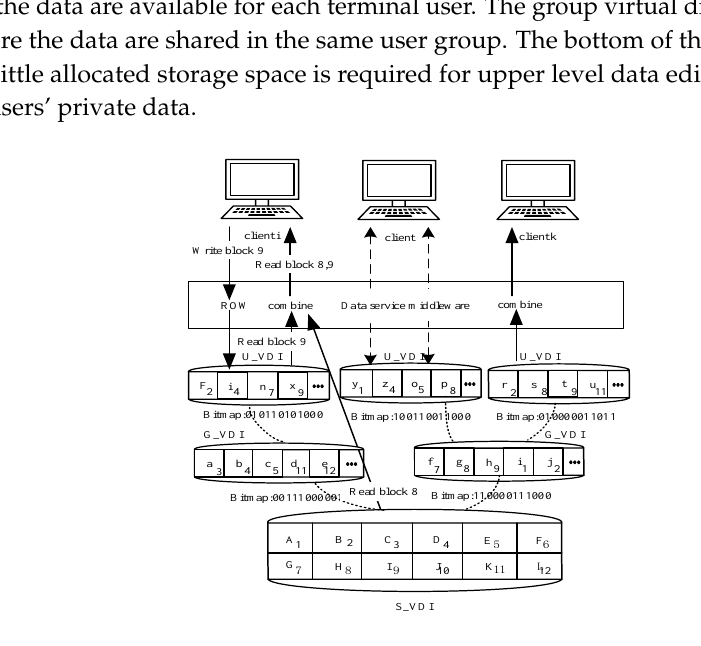
Figure 6. The Vdisk storage model and accessing